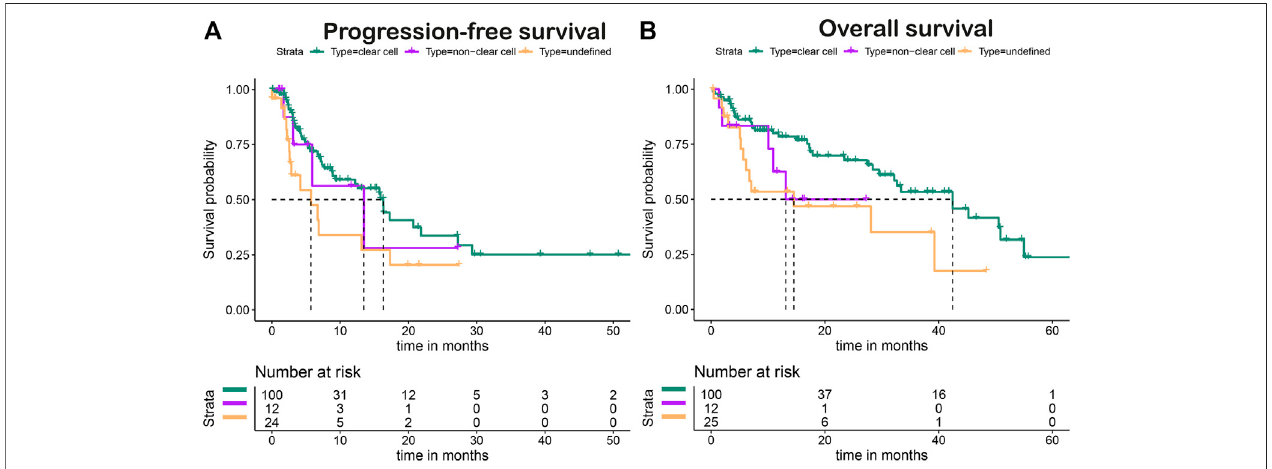
FIGURE 5 | Progression-free (A) and overall (B) survival of clear cell versus non-clear cell histology.